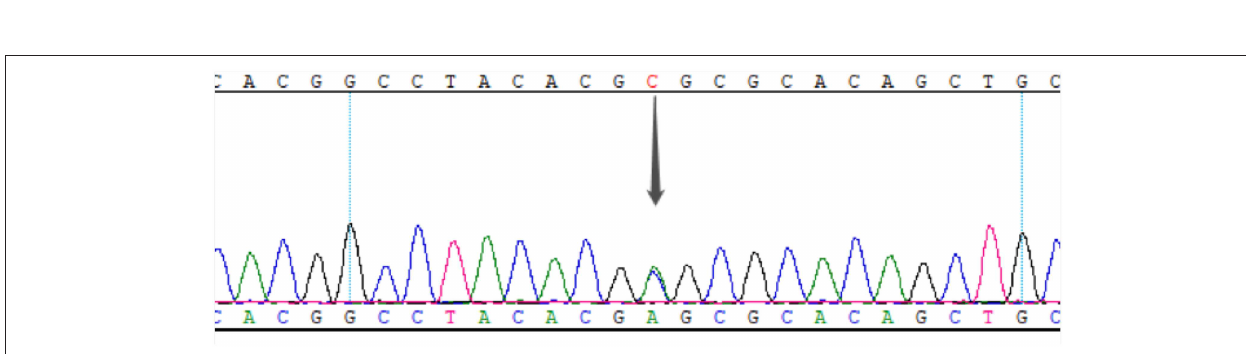
FIGURE 1 | Filled black symbols represent individuals with diabetes. Age of diabetes onset (a) and present age (b) are represented as a/b. MN represents PDX1c. 463C > A heterozygous mutation and NN represents the wild-type PDX1 gene. The remaining number represents BMI. Red arrow indicates the proband.